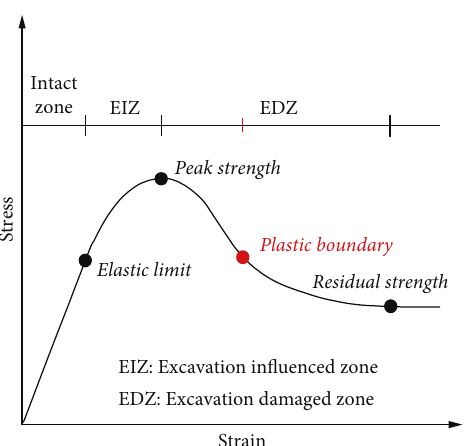
Figure 3: Locations of excavation-in fl uenced zone, excavation damaged zone, and plastic boundary in the stress-strain curve (modi fi ed from Renaud et al. [19] and Wang et al.